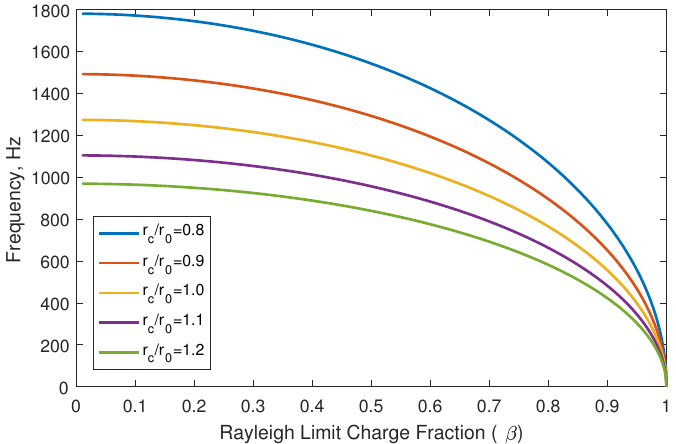
Figure 11. Oscillating cone frequency predicted by Equation (14). Meniscus radius, r c is taken to lie between 0.8 and 1.2 times the capillary diameter, r 0